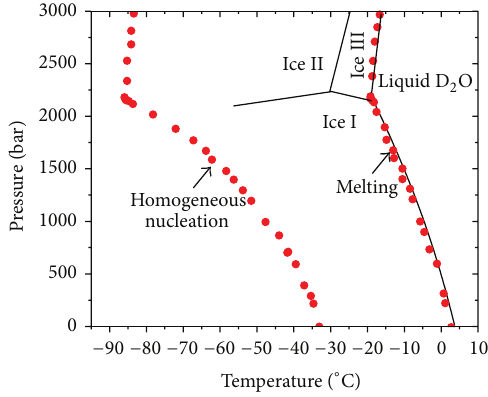
Figure 20: The phase diagram of heavy water is reported along with the melting and homogeneous nucleation curves measured in [42] (red dots).